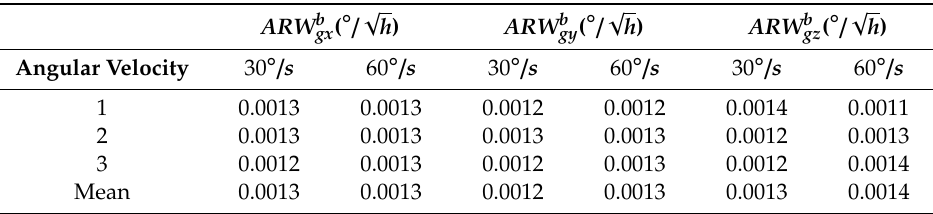
Table 6. Experiment results in mechanically dithered